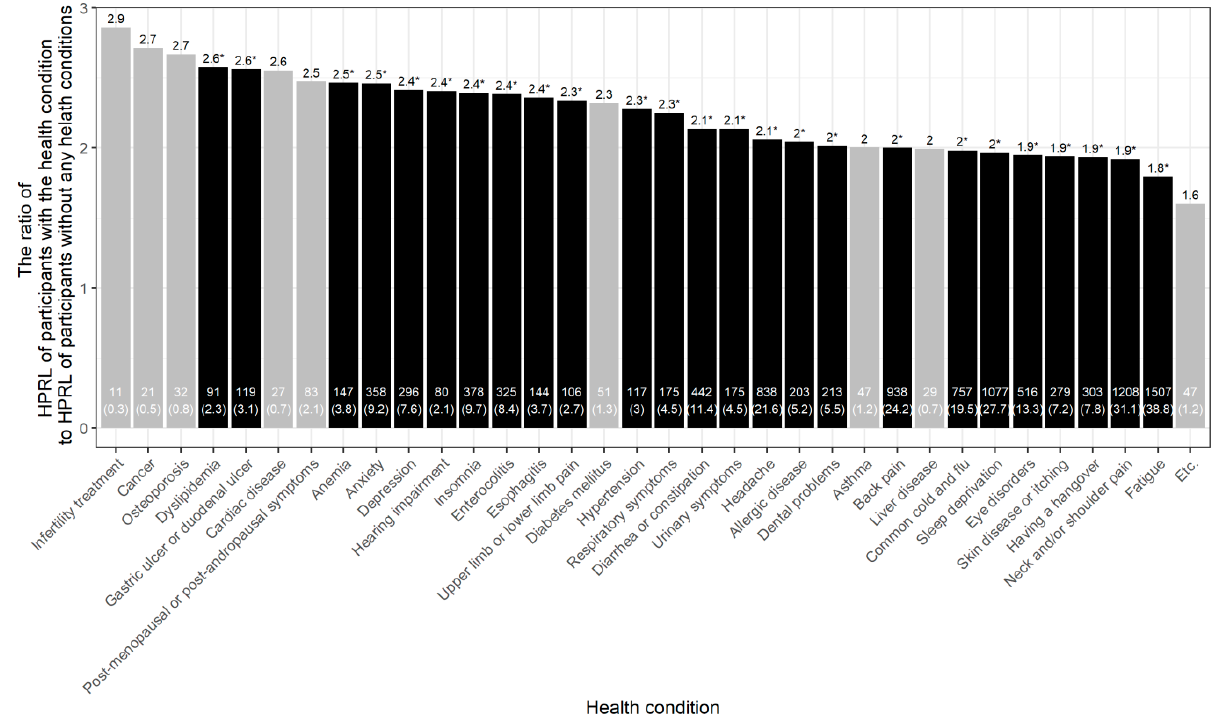
Figure 1. Percent health-related productivity loss among workers with specific health conditions compared to that of participants without any health conditions. The number and percentage of workers who complained of specific health conditions are presented at the bottom of the bar plot. The ratio of HRPL loss between participants with specific health conditions and that between healthy participants (without any health conditions) was calculated with the adjustment for age, gender, education level, household income, marital status, employment status and weekly working hours. * p < 0.0014 was in